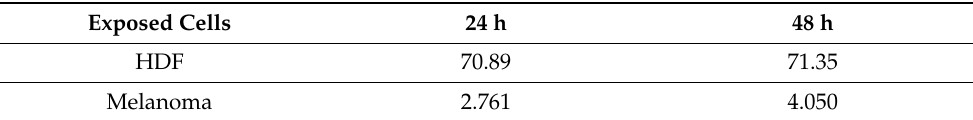
Table 4. Half-maximal inhibitory concentration (IC 50 ) values ( µ g/mL) for the AV-TeNPs cultured with HDF and melanoma